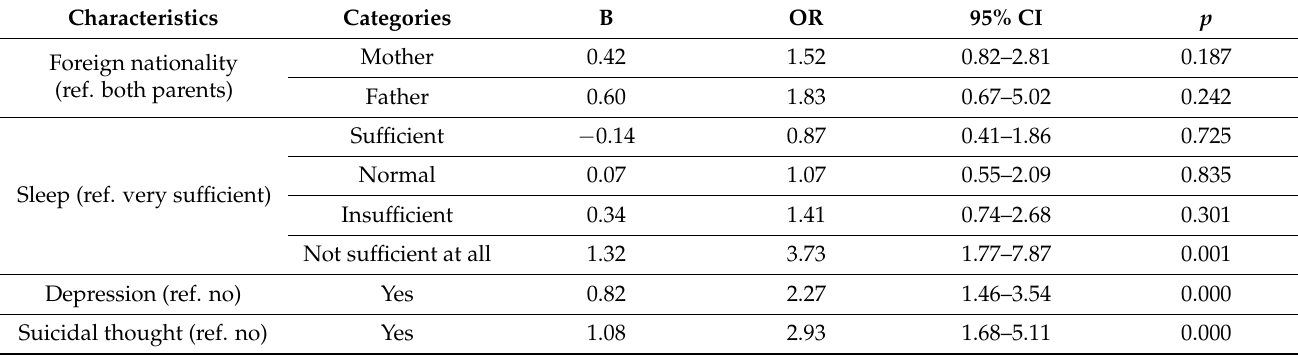
Table 2. Factors influencing stress among multicultural adolescents ( n =